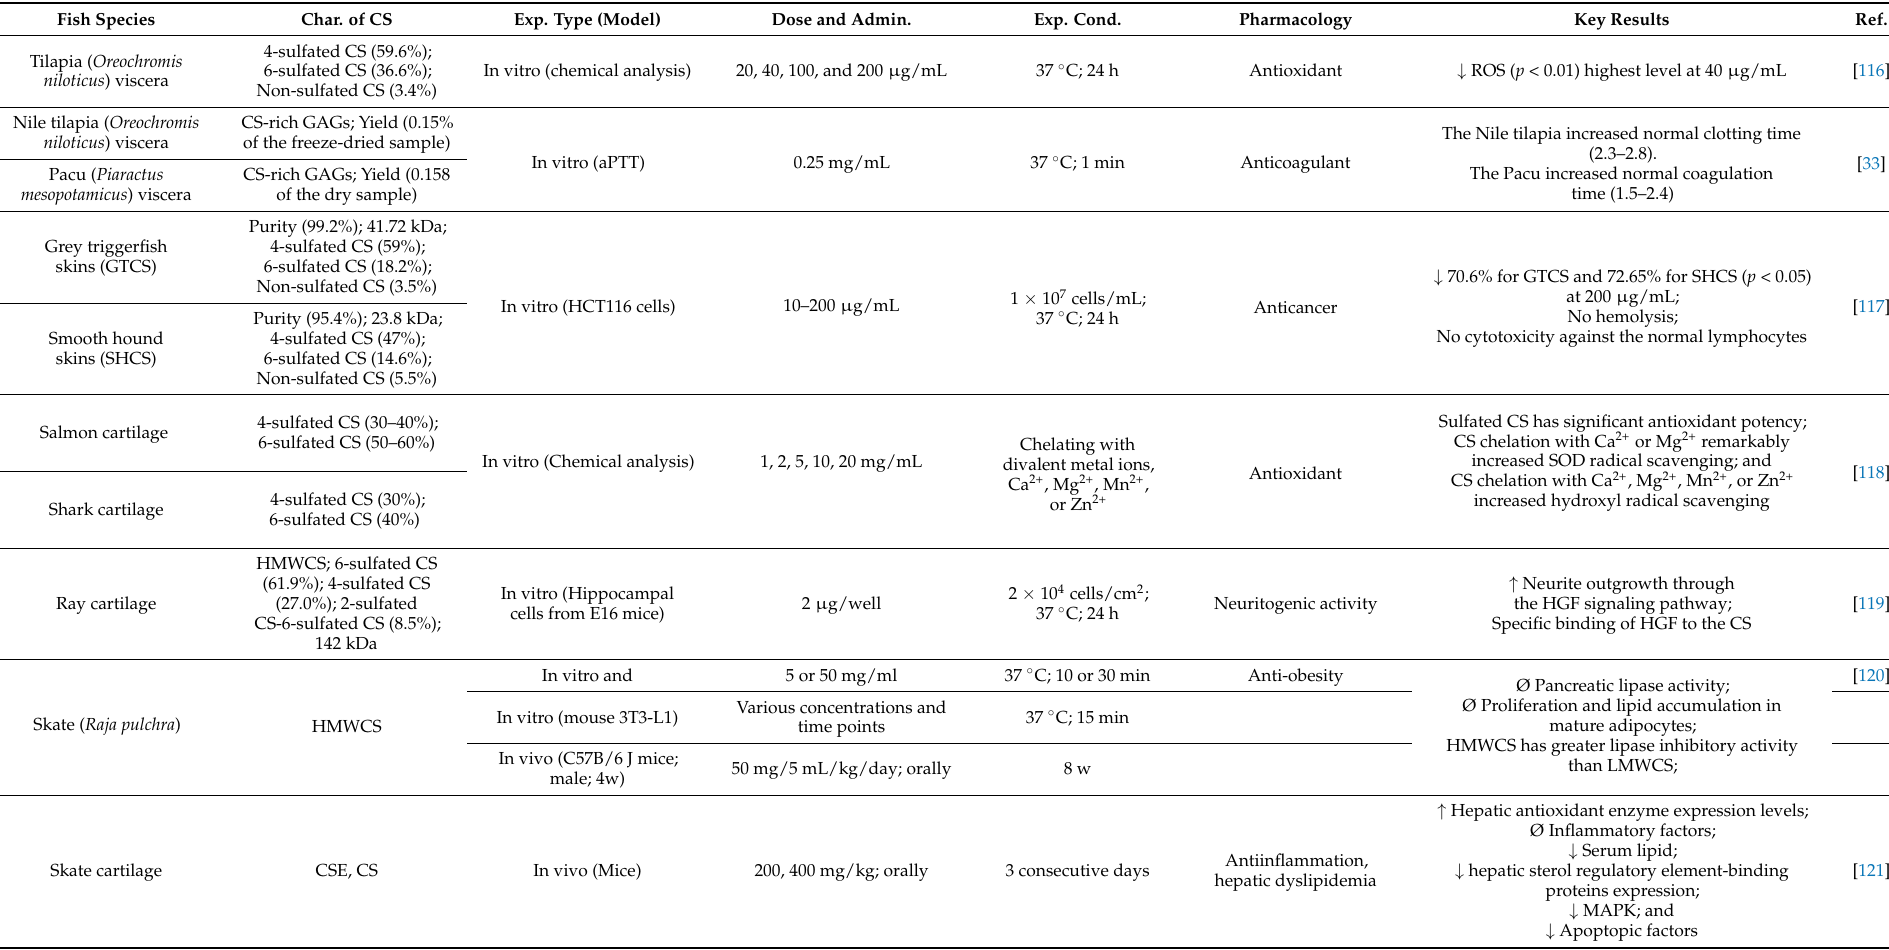
Table 3. Pharmacological activities of CS from different fish